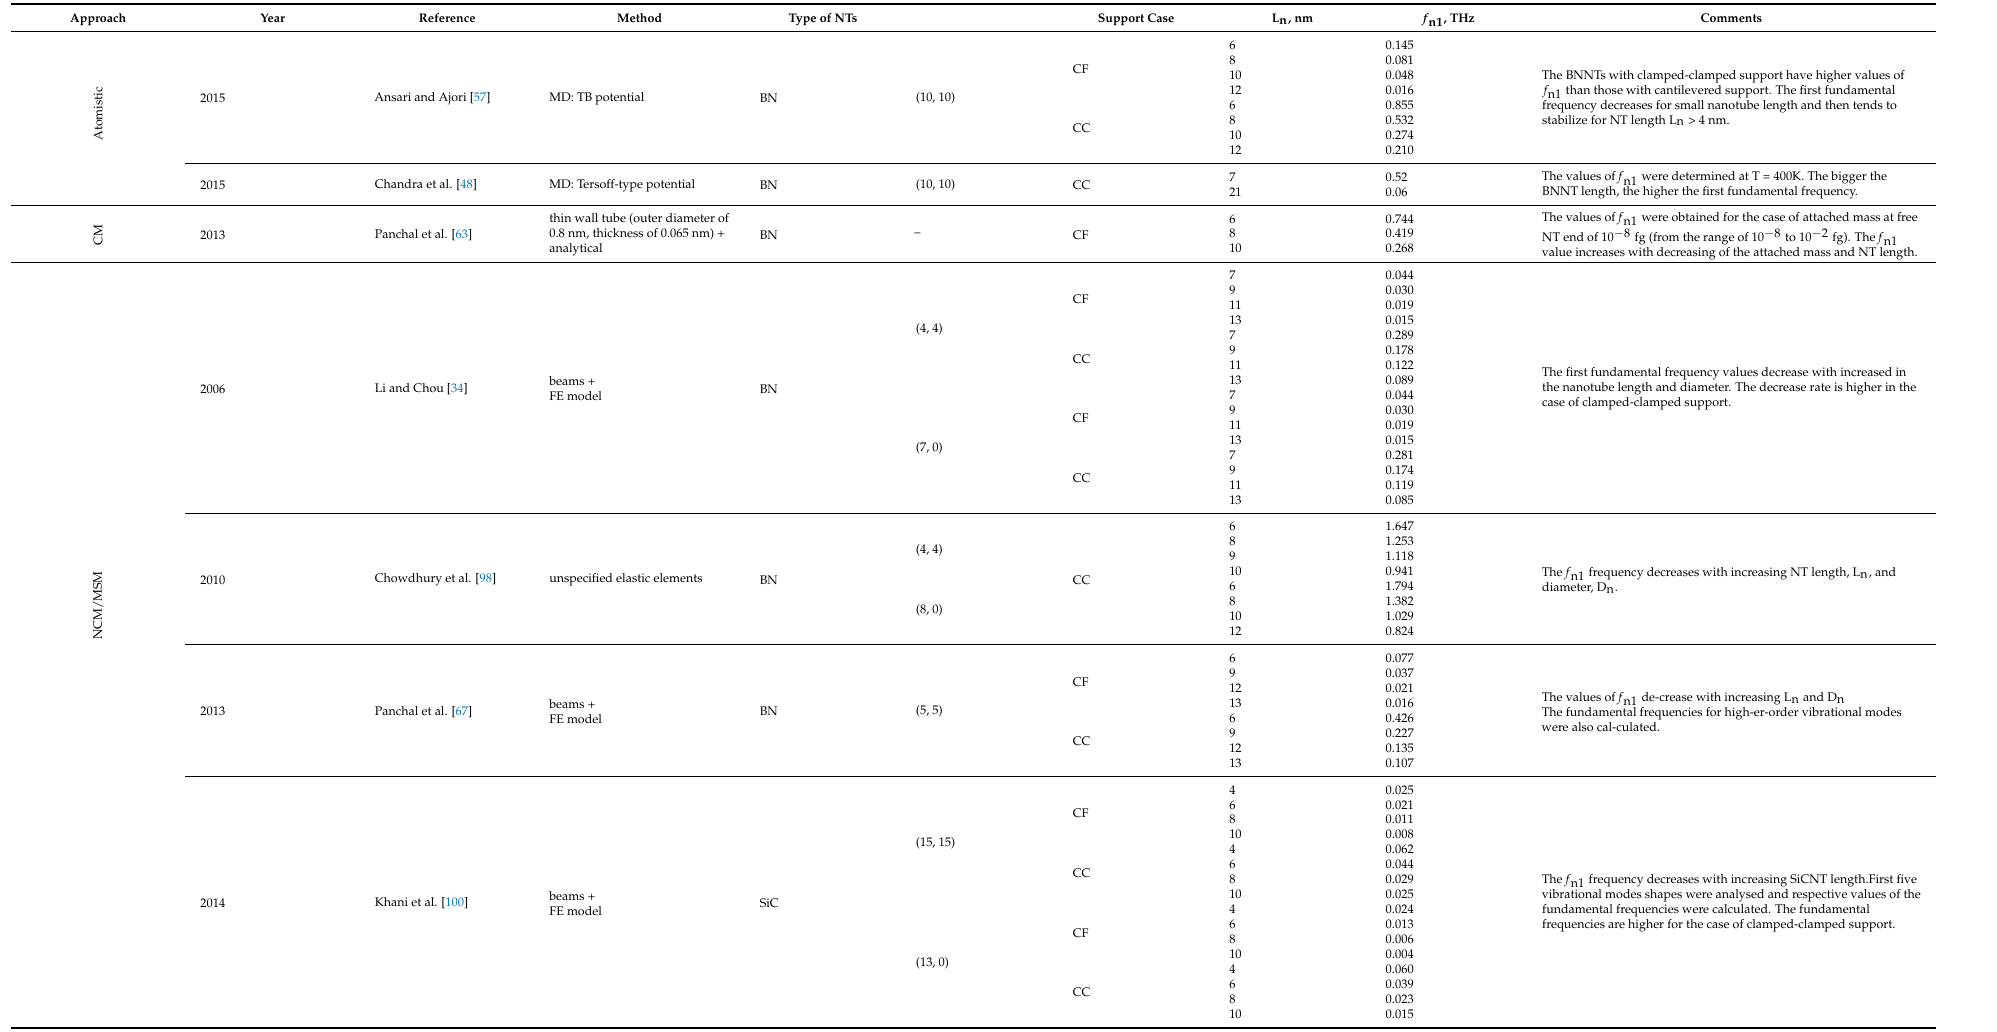
Table 4. Vibrational properties of N-CNTs available in the